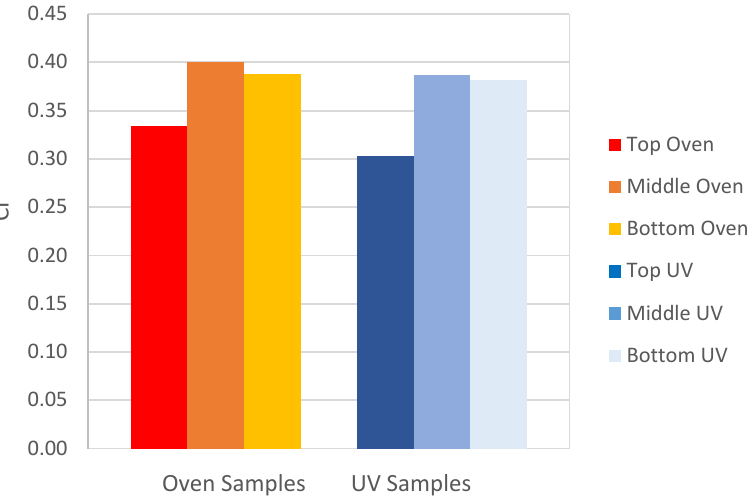
Figure 6. Average colloidal instability of extracted bitumen samples.